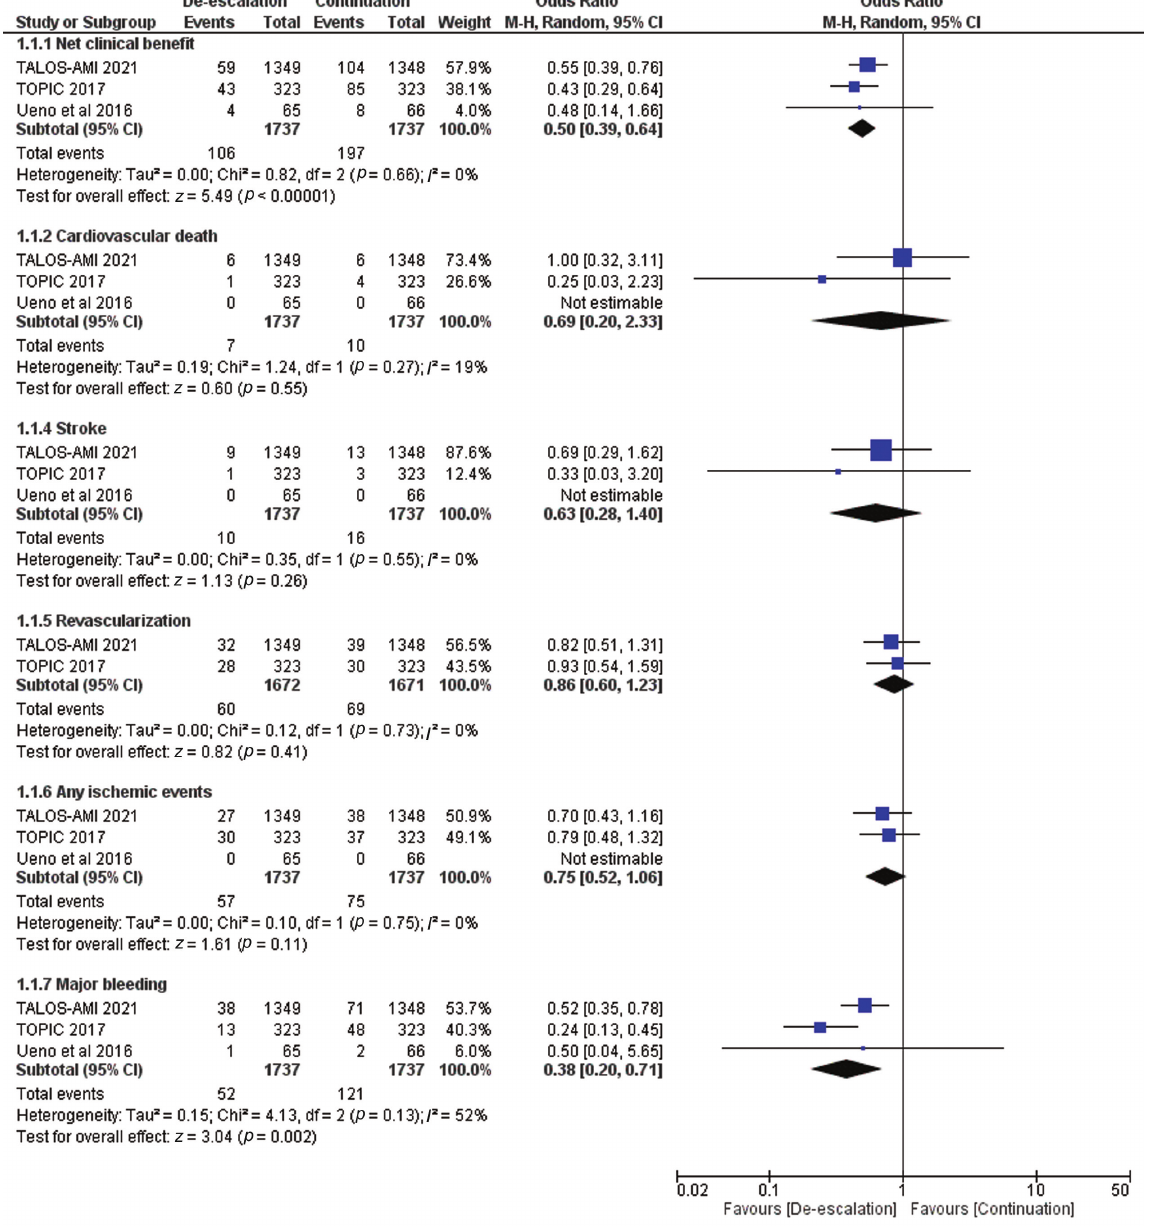
TH Open Vol. 00 No. 0/2022 © 2022. The